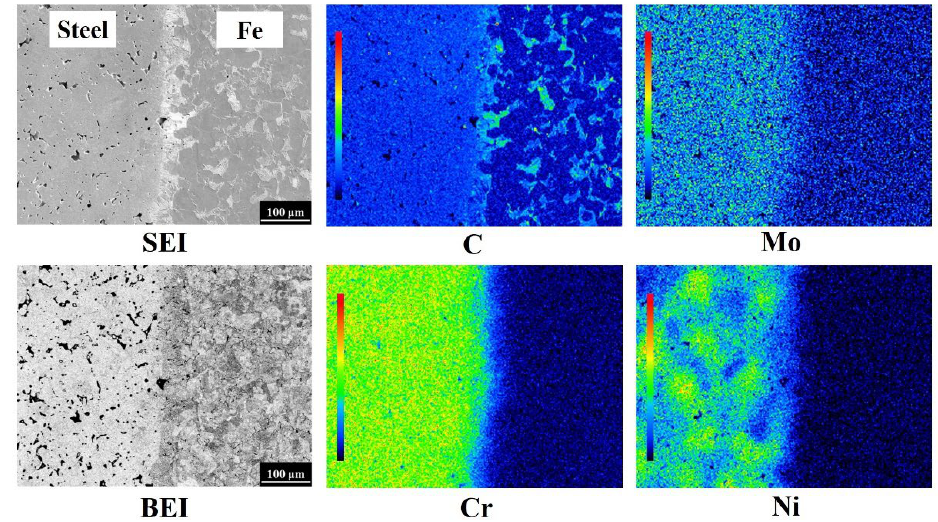
Figure 4. EPMA elemental distributions at the interface of the Fe-4Ni-3Cr-0.5Mo-0.5C/Fe